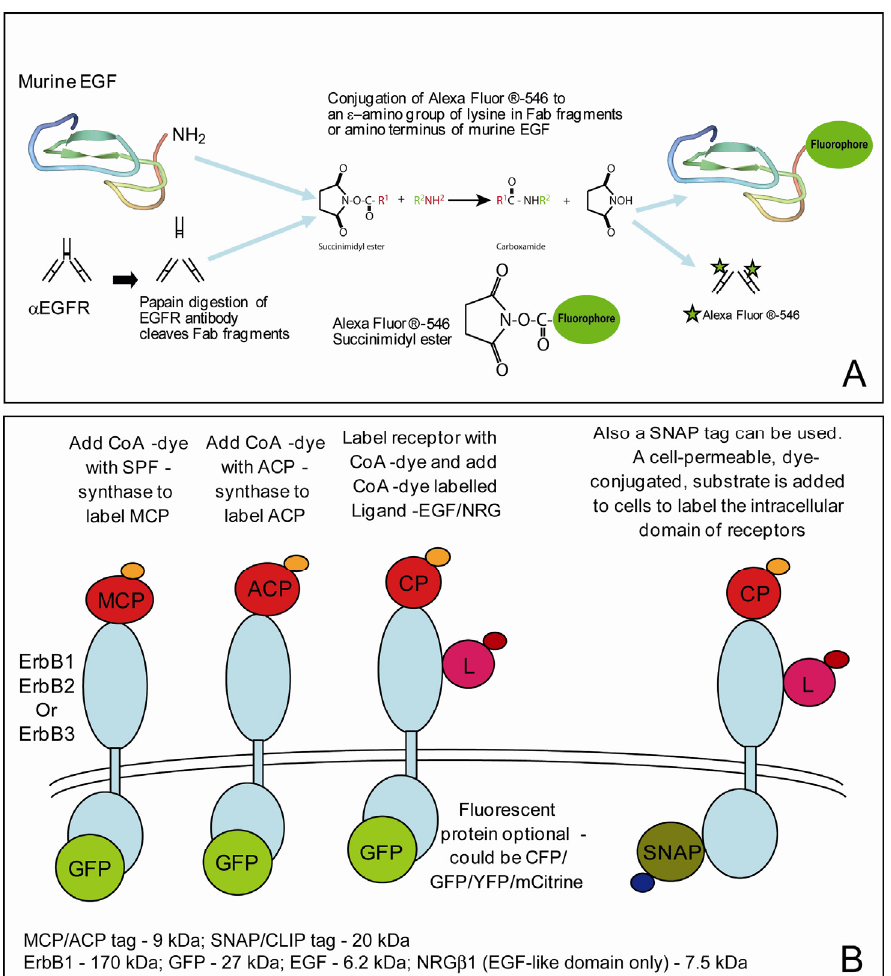
(Figure 2A). The desired 1:1 dye/ligand stoichiometry is easy to achieve if ligands do not have any lysine residues, such as, for example, the epidermal growth factor (EGF) ligand which binds the extracellular domain of HER1, because the dye can only bind the N -terminus. Similarly, 1:1 stoichiometry can be easily obtained with ligands that have a single cysteine residue, such as, for example, affibody ligands. If two cysteines are present, it is often possible to mutate one to another small amino acid whilst maintaining good affinity for the receptor. Figure 2. Illustration of methods used for fluorescence labelling. ( A ) Conjugation of fluorophores to ligands and antibodies; ( B ) The use of combined methods for multiple labelling of proteins with different ligands: The intracellular domain is labelled with green fluorescent protein and/or SNAP tags, while the extracellular domain is labelled using a combination of MCP, ACP, and CLIP tags, and chemically-conjugated